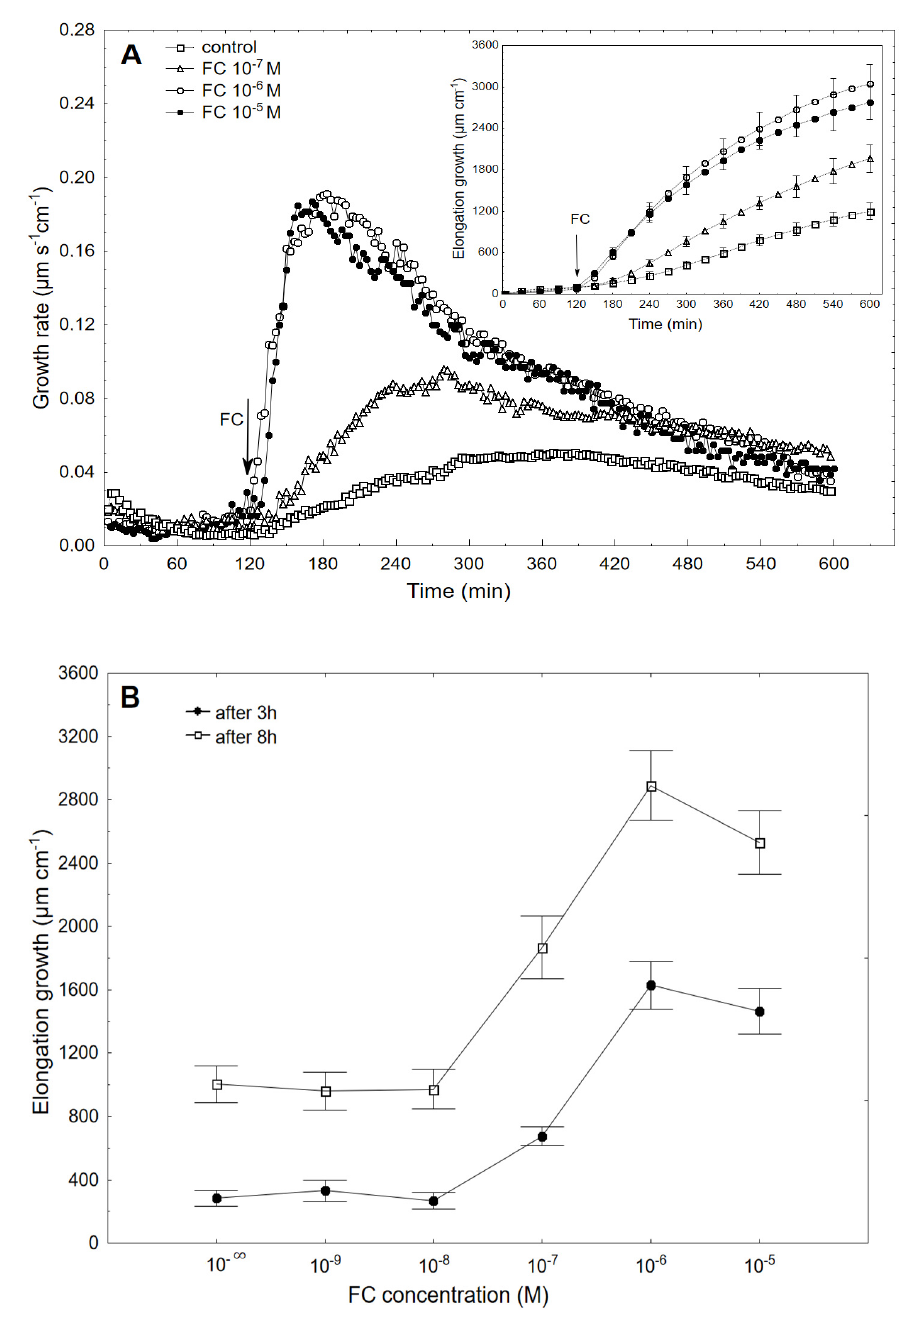
Figure 1. Growth rate ( µ m s − 1 cm − 1 ) of the maize coleoptile segments that had been incubated in the presence of 10 − 7 , 10 − 6 and 10 − 5 M of FC ( A ) and the dose–response curves for the FC (10 − 9 –10 − 5 M)- induced total elongation growth of the coleoptile segments as a function of time ( B ). The coleoptile segments were first preincubated (over 2 h) in a control medium to which FC had been added (arrow). The inset in Figure 1A shows the total elongation growth ( µ m cm − 1 ), which was calculated as the sum of the extensions from 3 min interval measurements over 10 h. All of the curves are the means of at least five independent experiments. Bars indicate ±